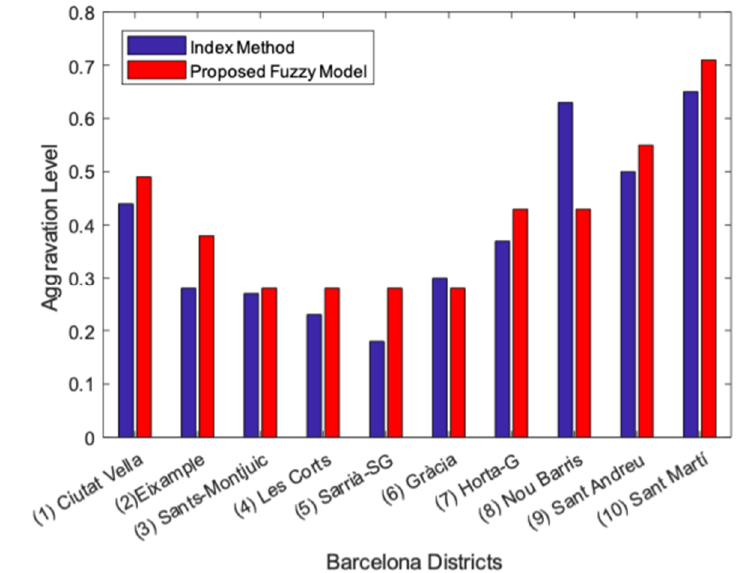
Figure 5. Aggravation values obtained for the 10 districts of Barcelona with the index method and the proposed fuzzy model.